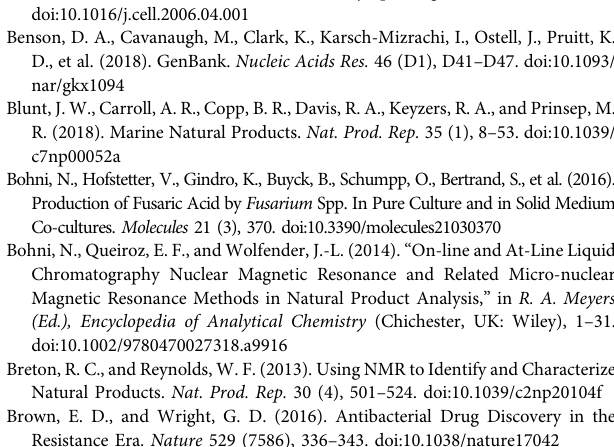
for S. aureus and P. aeruginosa ,